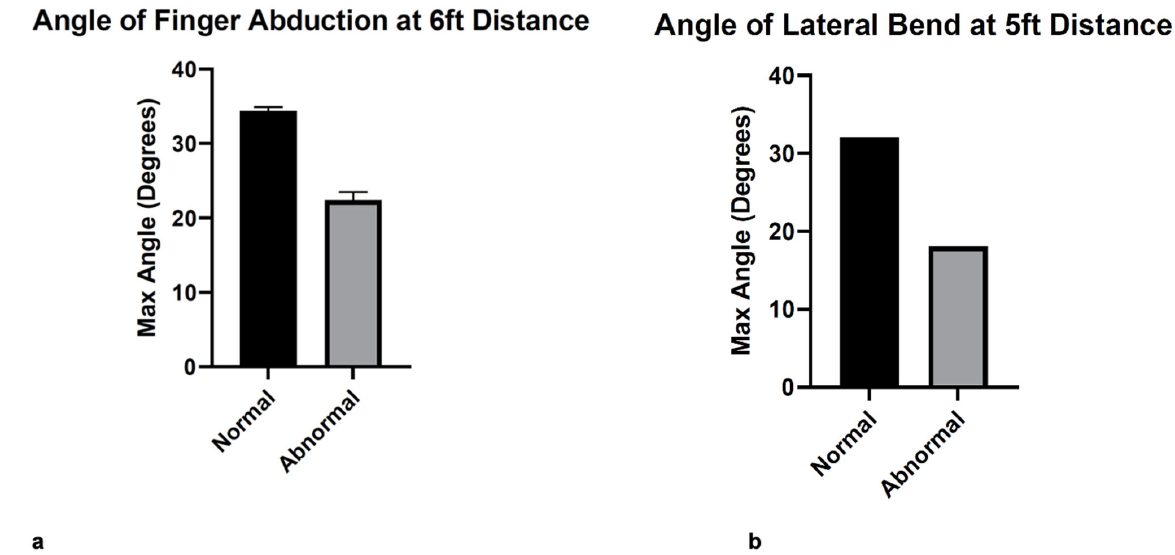
Figure 11. ( a ) Max angle of finger abduction captured at 6 ft distance using 2 mm markers. ( b ) Max angle of lateral bend test captured at 5 ft distance using 10 mm markers.